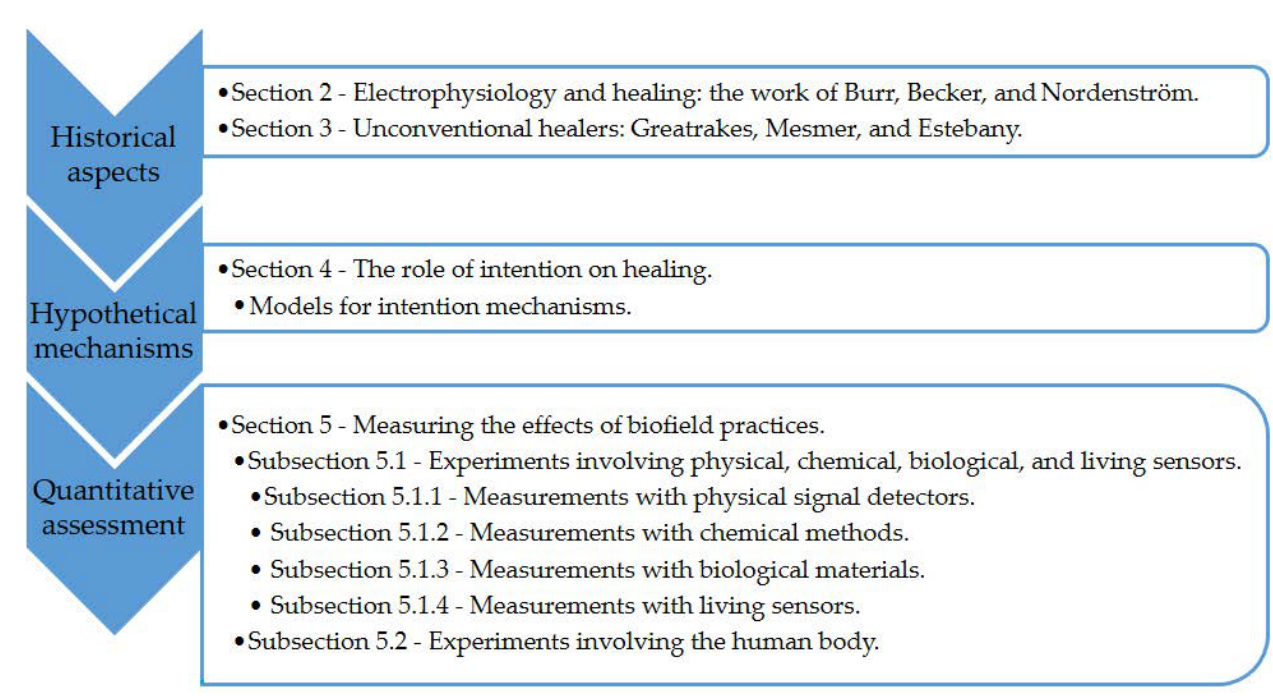
Figure 2. Sequence overview of the main topics covered in the present narrative